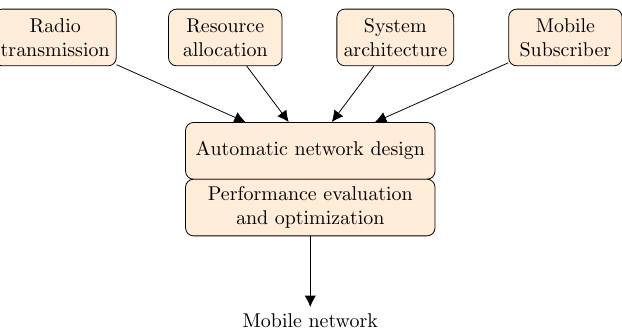
Figure 2. Sophisticated network planning.